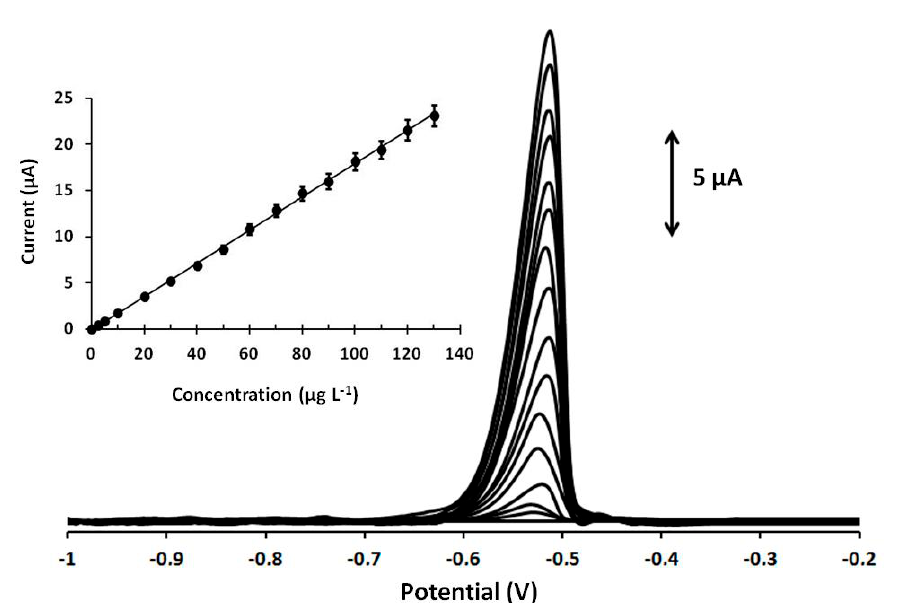
Figure 4. DP voltammograms at the Ca-MOF/GPE for increasing concentrations of Pb(II) in the range of 0–130 µg L − 1 (0, 2.5, 5, and 10–130 with a 10 µg L − 1 step of Pb(II)). The corresponding calibration plot is shown as an inset. Each bar is the mean value ± sd (n = 3). Supporting electrolyte: 0.1 mol L − 1 acetate buffer (pH 4.5); preconcentration potential: − 1.2 V; preconcentration time: 360 s. Other DPASV parameters were pulse 40 mV for 10 ms and scan rate 10 mV s − 1 .